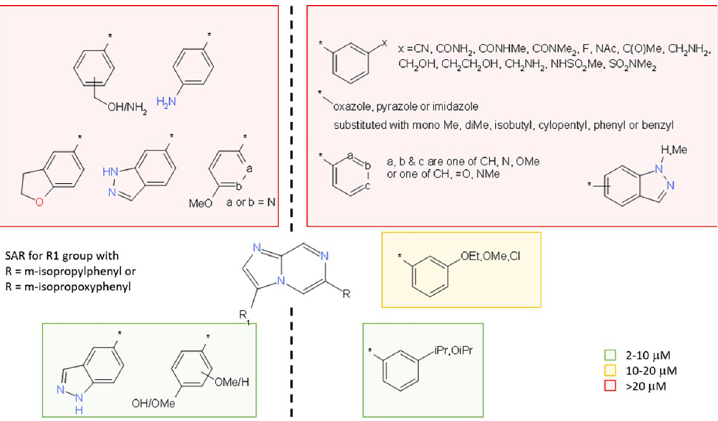
Fig 2. Compound library SAR. Illustration of the structure activity relationship derived from an exploratory set of compounds made as a combinatorial compound library and tested in vitro against S . mansoni juvenile worms for 5 days. Colour coded to show EC 50 values.